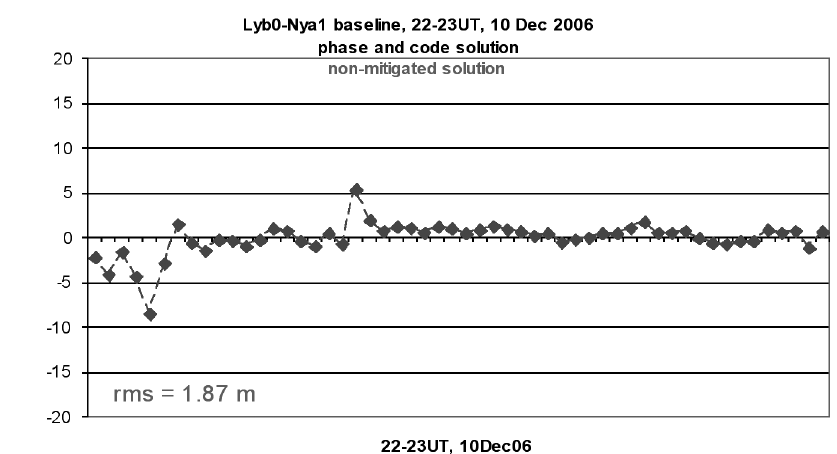
Fig. 21. Height errors from pseudoranges and carrier phase solution without